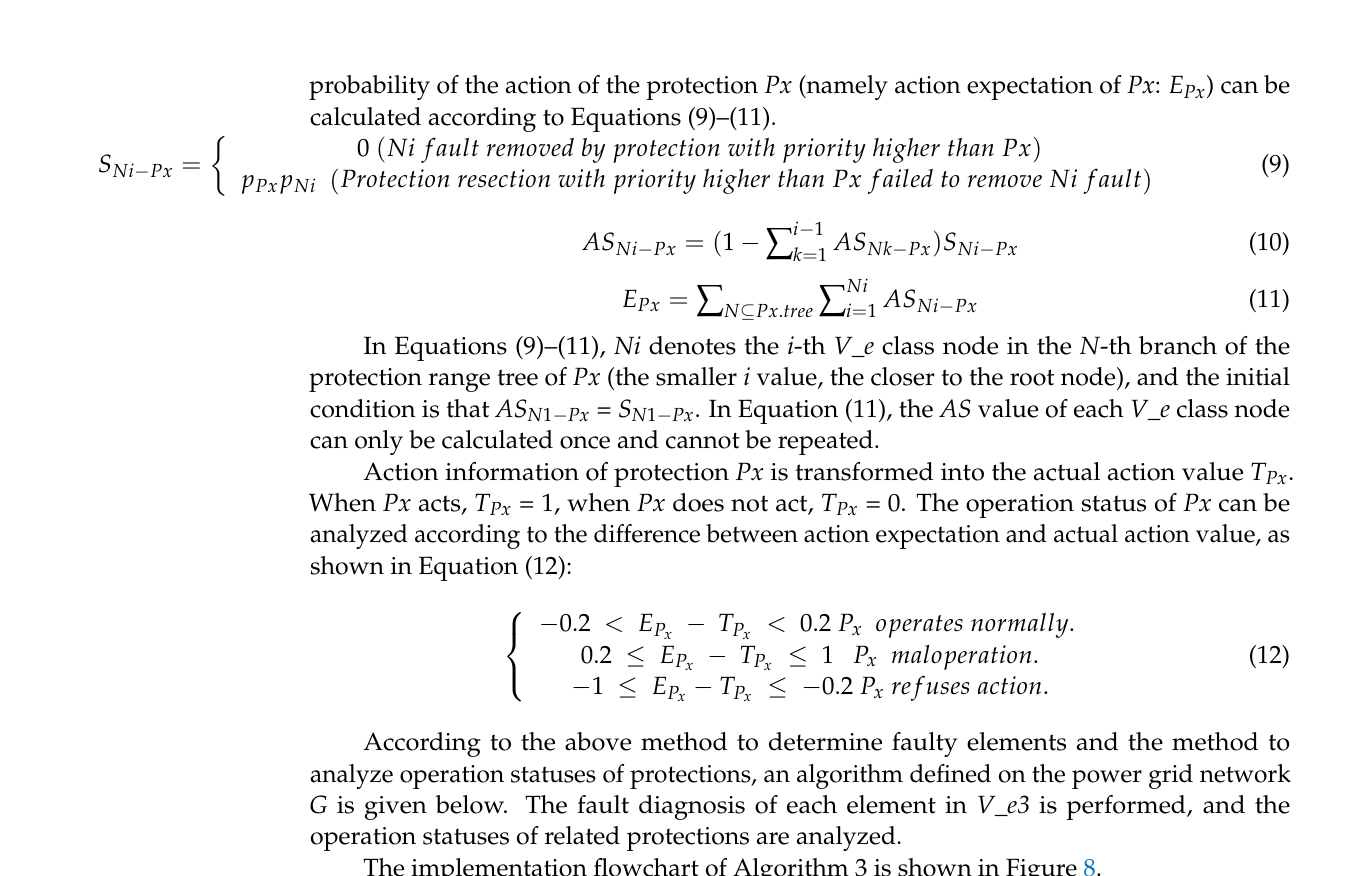
Algorithm 3 Faulty elements determination and operation status analysis of related